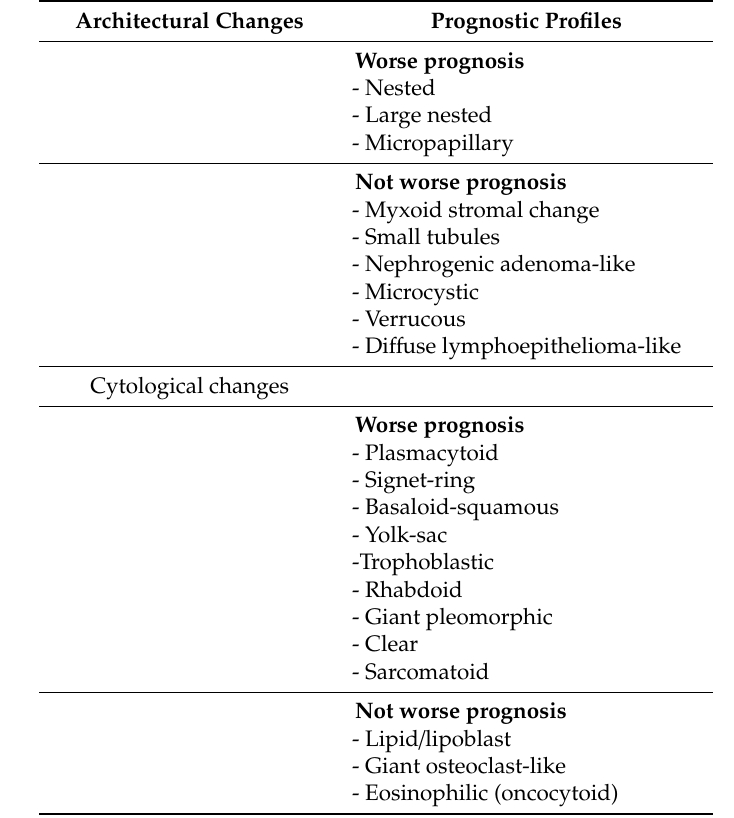
Table 1. Unusual features in bladder cancer with prognostic